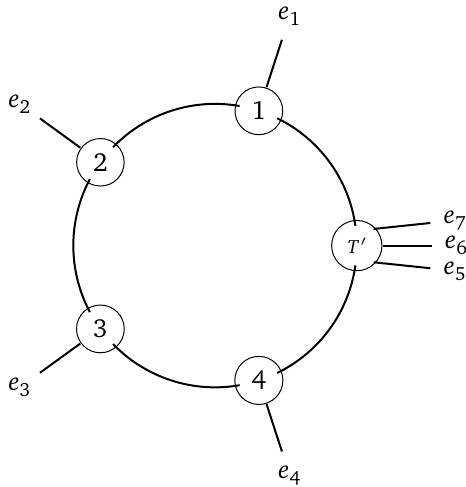
Figure 11: The tensor network in Figure 10 is shown after contracting along the 5 − T edge. The tensor which results is labeled T (cid:48) and has rank 5, an increase of one from the larger of the two input tensors.